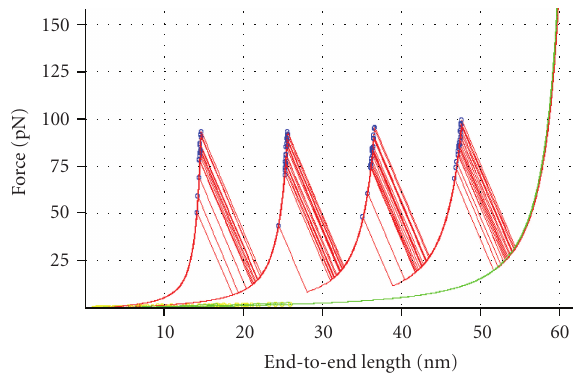
Figure 4: Monte-Carlo simulation of force versus extension data of Z1Z2 using (2) and (3). Data obtained in 15 consecutive stretch- release cycles at a pulling velocity of 100nms − 1 are displayed.